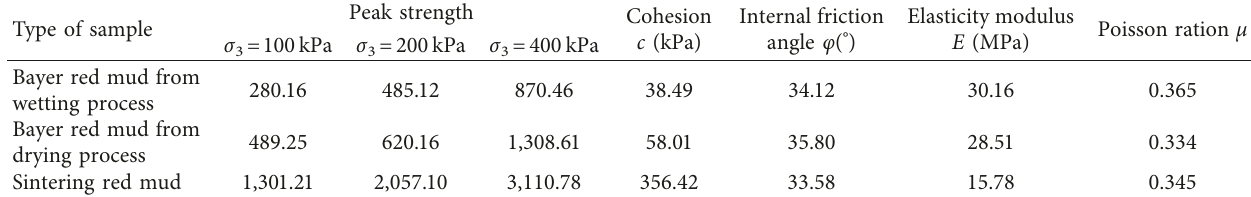
Table 3: Strength and deformation indicators of the three kinds of red mud.